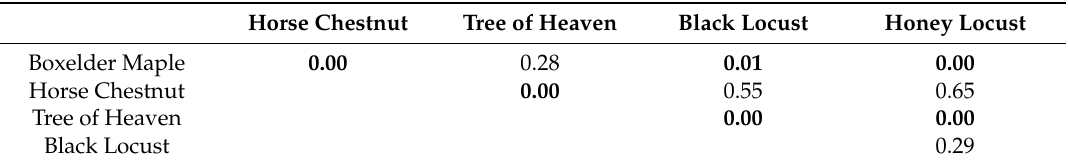
Table 6. Statistical di ff erence of the turning surface quality grades between di ff erent tree species expressed by the p -value of the ANOVA analysis. The values in bold indicate a significant di ff